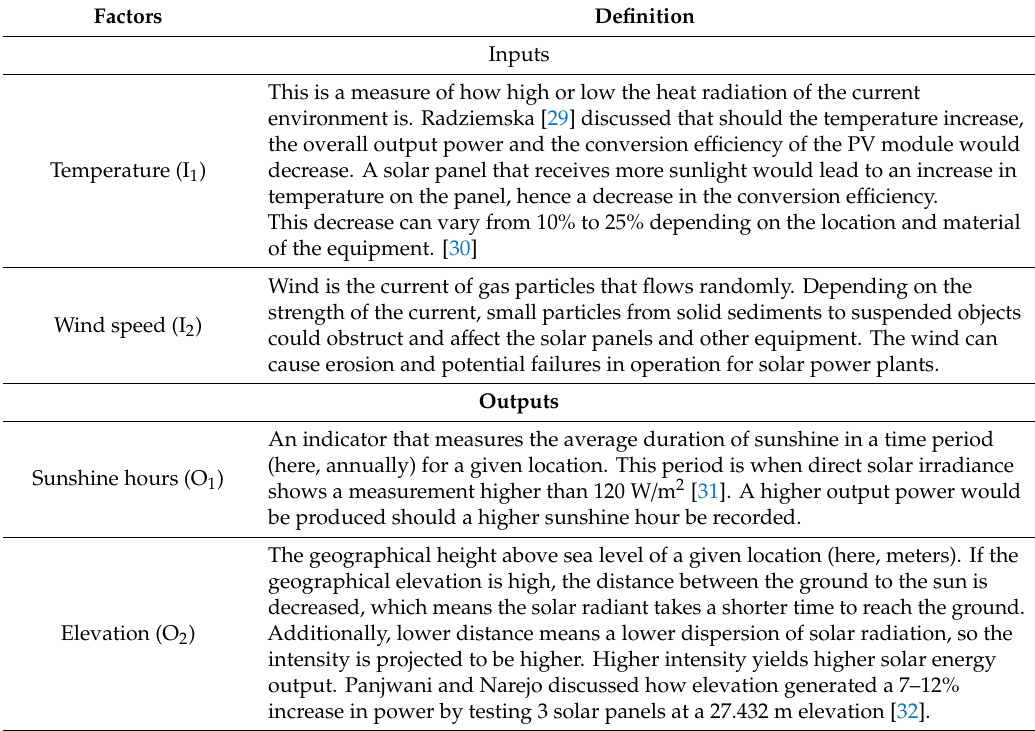
Table 4. Definition of inputs and